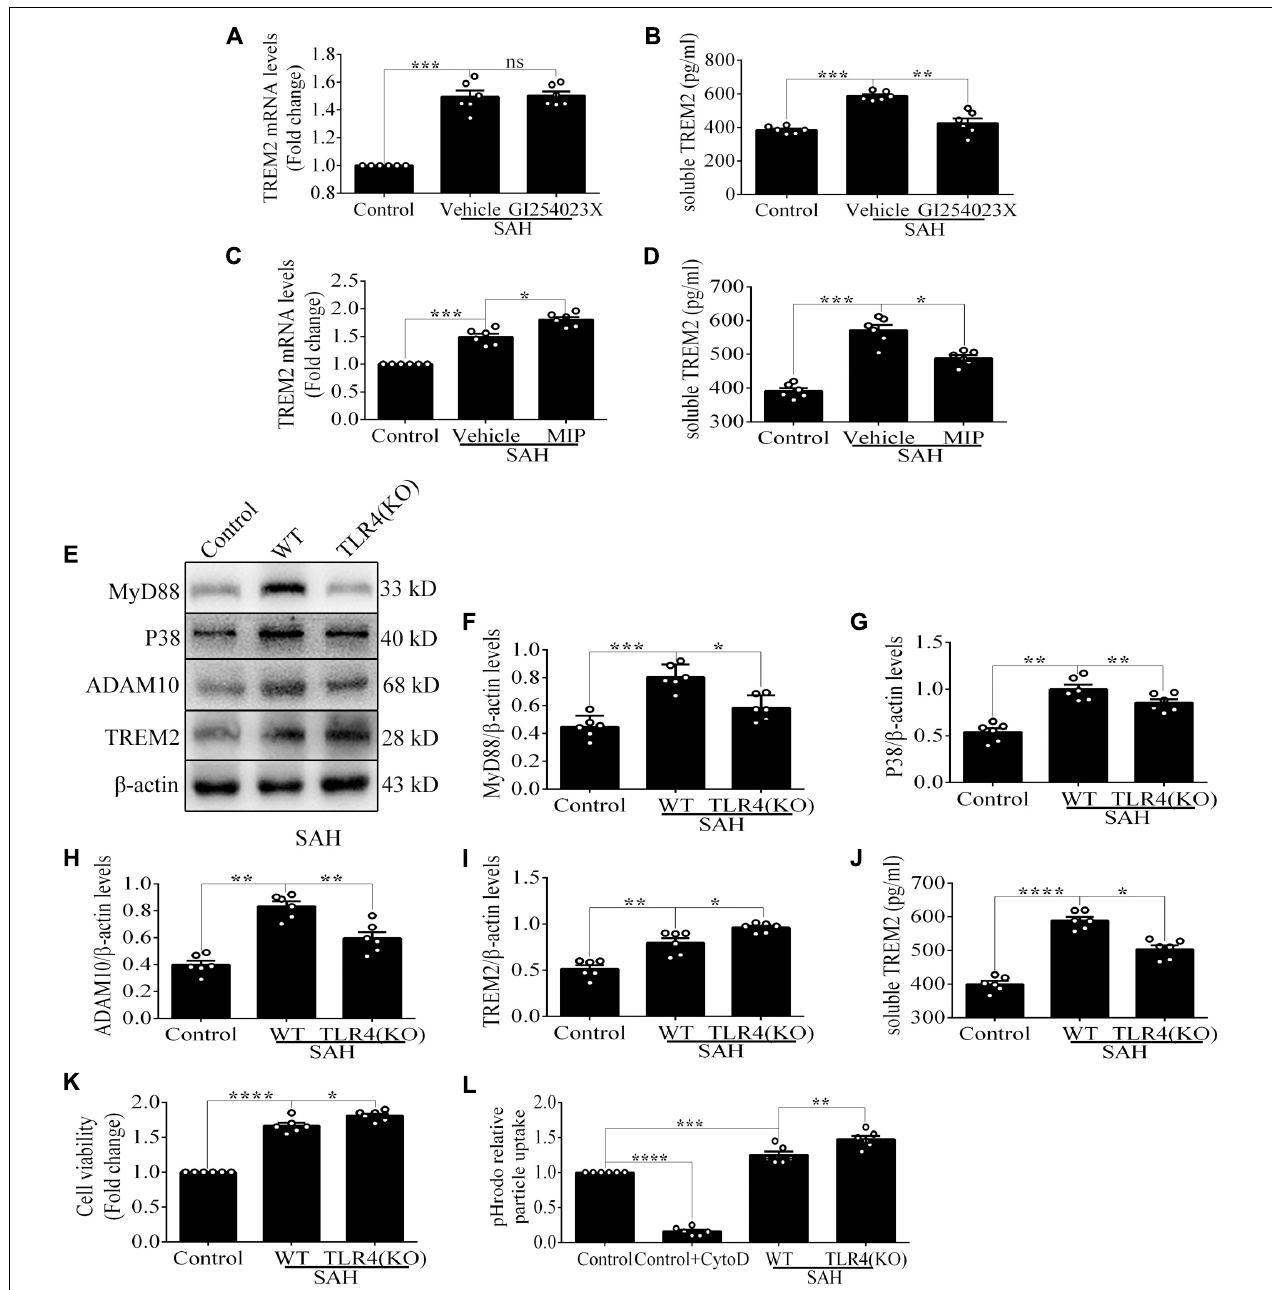
FIGURE 4 | Toll-like receptor 4 ( TLR4 ) pathway is involved in regulating the expression of triggering receptor expressed on myeloid cells 2 ( TREM2 ) in vitro after subarachnoid hemorrhage (SAH). (A–D) Infusion with GI254023X or MyD88 inhibitory peptide (MIP) fusion protein was used to detect the regulatory effect of TLR4 on TREM2 . (E–I) The protein levels of MyD88, P38, ADAM10, TREM2 , and β -actin were quantified by Western blotting. (J) ELISA detection showed the changes of soluble TREM2 . (K,L) The microglial viability and phagocytic capacity were measured to assess microglial activity associated with TREM2 . These data are shown